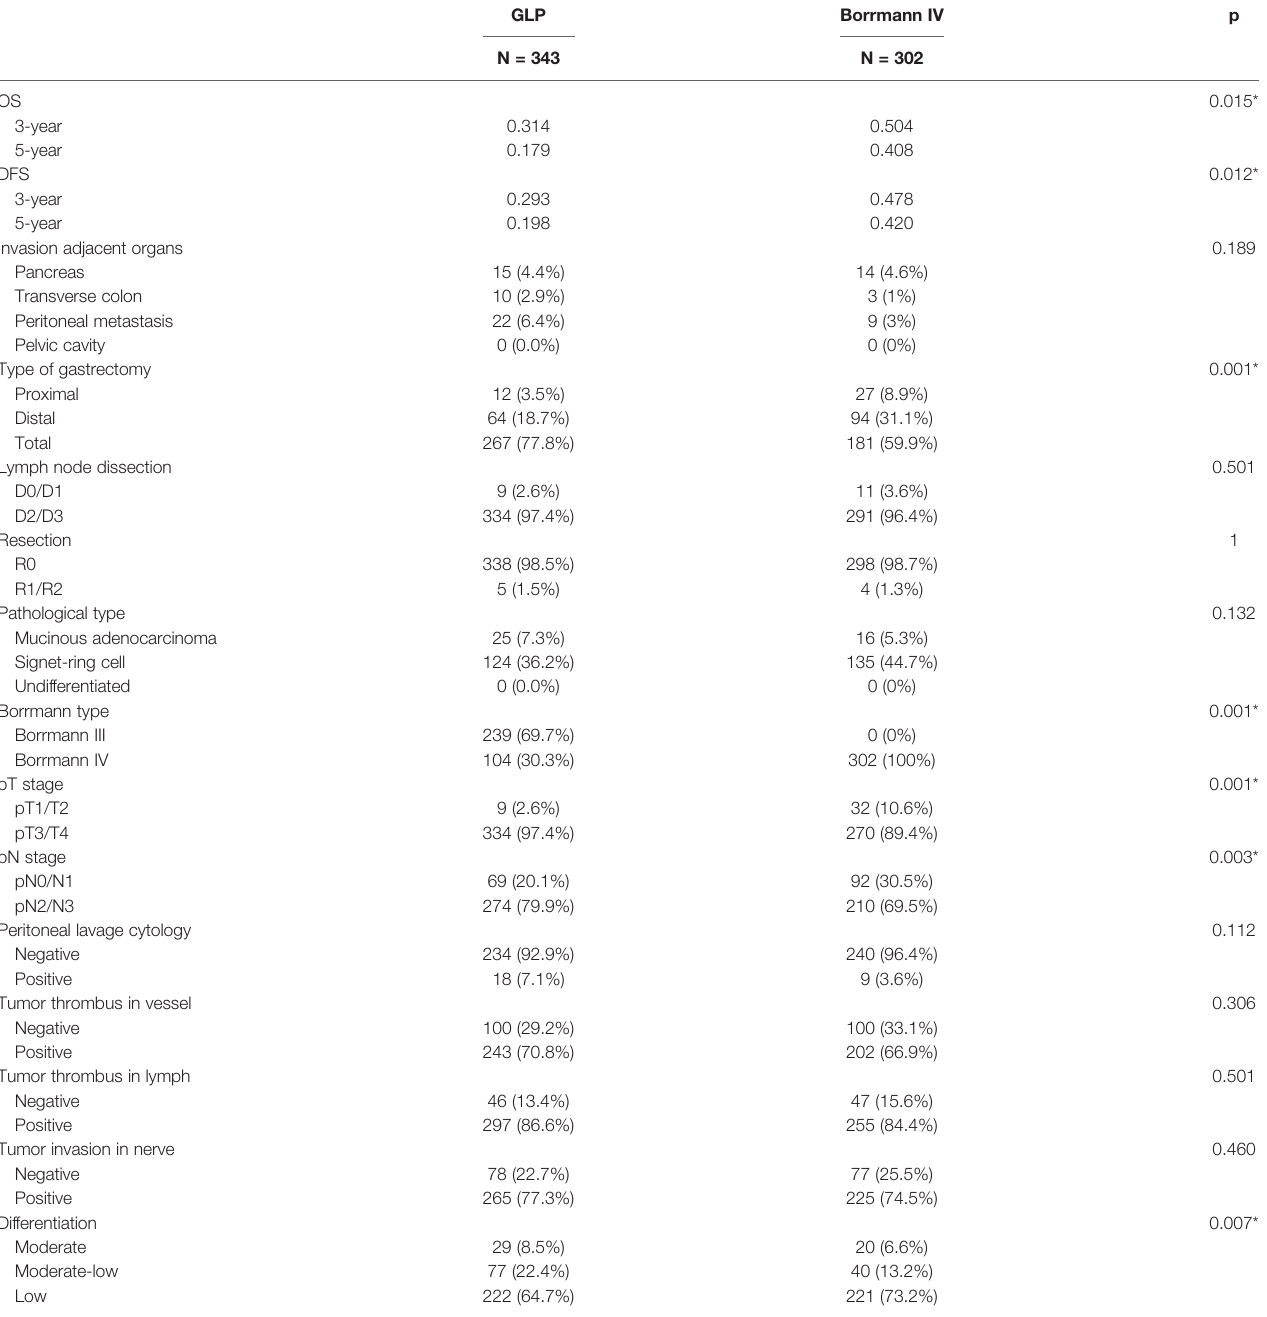
TABLE 3 | The difference of the clinicopathological features between GLP and Borrmann IV